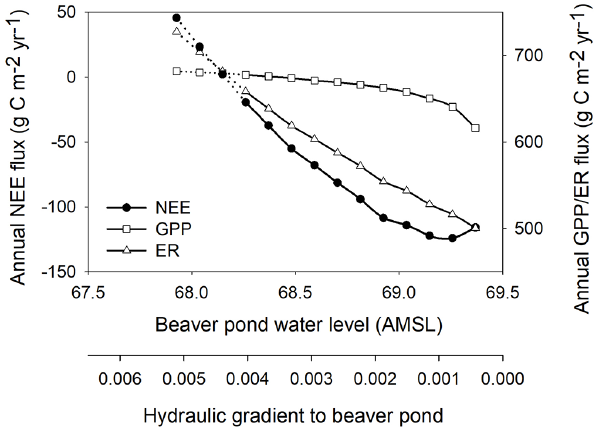
Figure 7. Sensitivity of annual mean NEE, GPP, ER to the varying beaver pond water level (thus lateral hydraulic gradient) for each 0.1m bin of the pond level over 1998–2019. The constant BP water level ranged from 67.9ma . s . l . (a dry pond) to the highest possible water level, 69.37ma . s . l . (the average measured WTD at the peat- land) when flow would reverse from the pond to the peatland. The solid line indicates the measured BP water table range. Note that the sign of NEE follows the atmospheric convention, negative meaning uptake, and GPP and ER are both plotted as